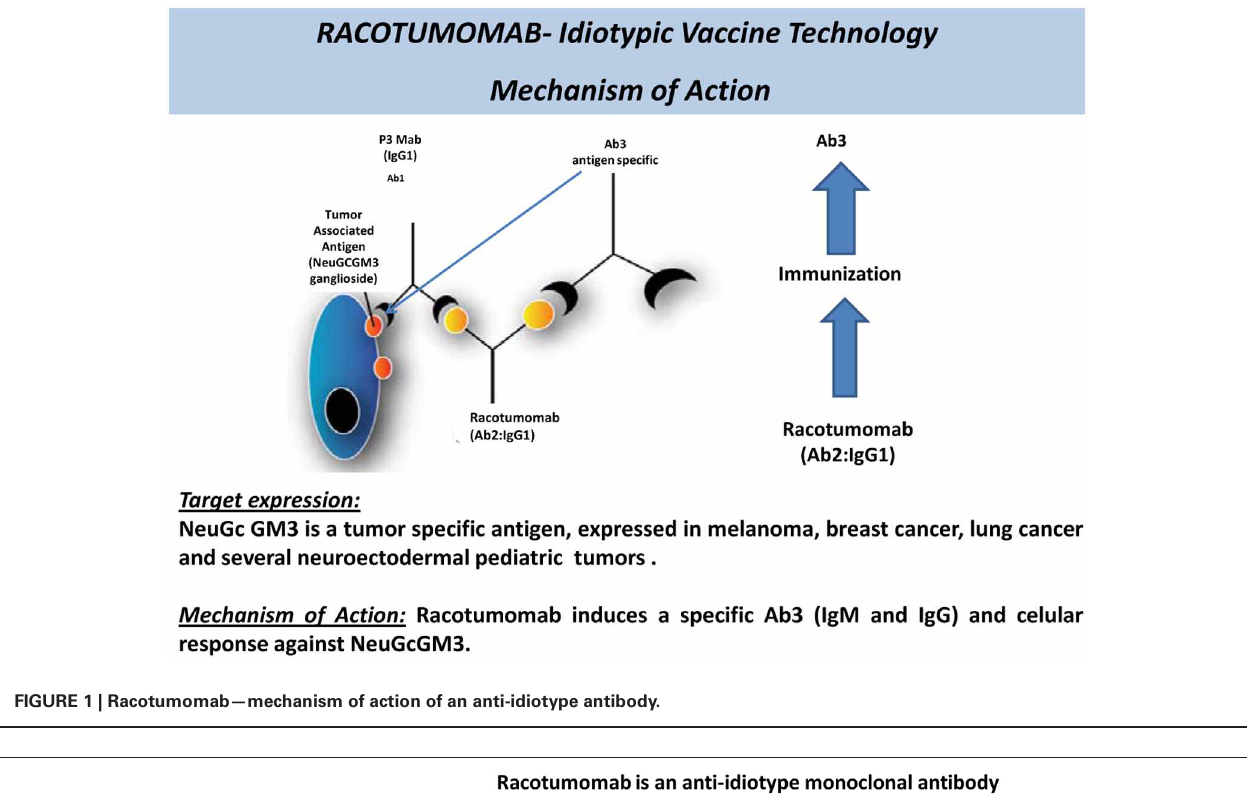
FIGURE 1 | Racotumomab—mechanism of action of an anti-idiotype antibody.